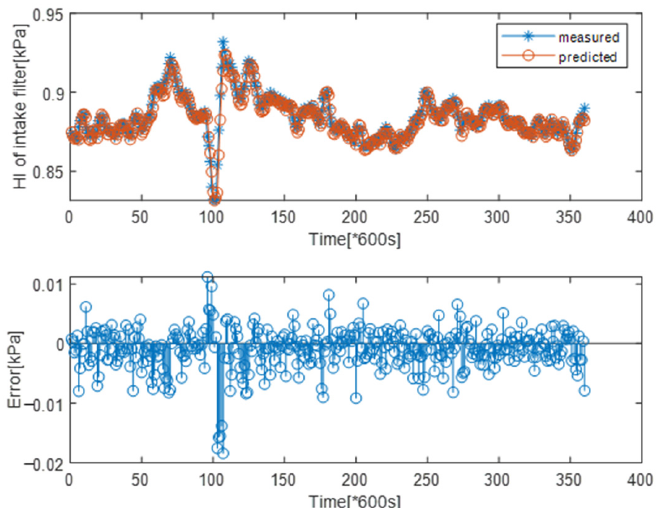
Figure 7. Performance degradation prediction results of the intake filter based on the LSTM net- work.